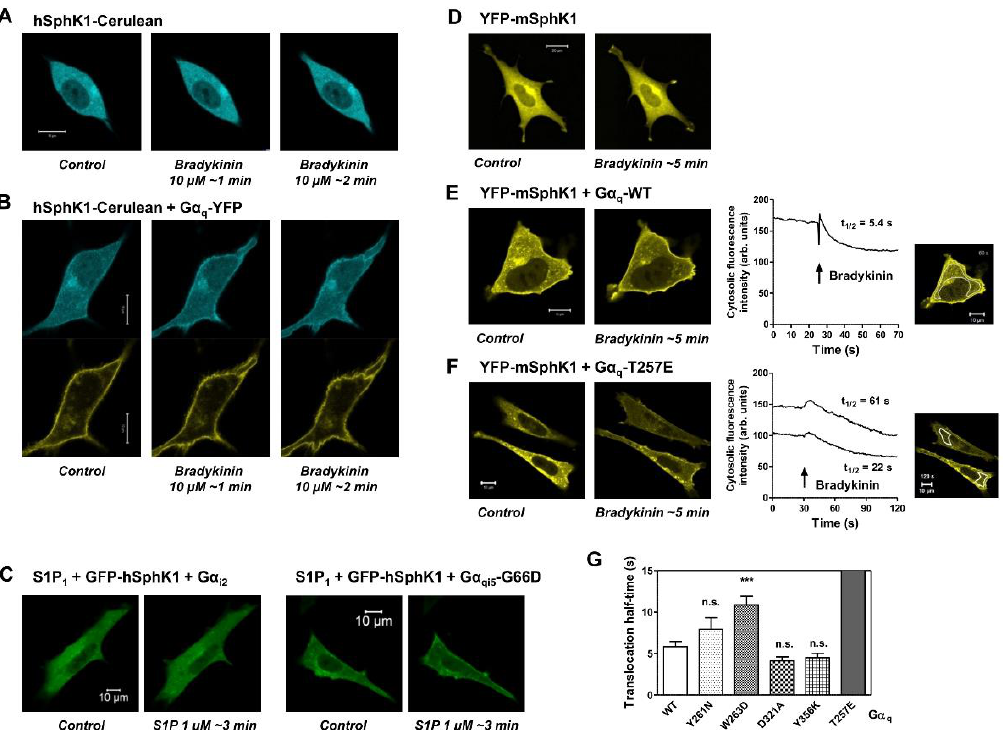
Figure 4. Identification of G α q residues required for G q / 11 -mediated SphK1 translocation. ( A – G ) SphK1 translocation was analyzed in G α q / 11 -double-deficient MEFs. ( A , B ) The cells were co-transfected with the bradykinin B 2 receptor and hSphK1-cerulean without ( A ) and with ( B ) G α q -YFP. Images were taken before and after addition of 10 µ M bradykinin as indicated. ( C ) The cells were co-transfected with the S1P 1 receptor, GFP-hSphK1, and either G α i2 or G α qi5 -G66D as indicated. Images were taken before and ~3 min after addition of 1 µ M S1P. ( D – G ) The cells were co-transfected with the B 2 receptor, YFP-mSphK1, and G α q wild-type (G α q -WT) or various G α q mutants as indicated. Images were taken at a high resolution before and ~5 min after addition of 10 µ M bradykinin. The time course of SphK1 translocation was measured by taking series of images at lower spatial resolution at ~1 image / 400 ms. Cytosolic fluorescence intensity was measured in selected regions as indicated in the inserts in ( E , F ), and translocation half-times were calculated by fitting exponential curves to the decay in the cytosolic fluorescence intensity. ( G ) Translocation half-times obtained with the various G α q mutants. Data are means ± SEM; n = 31 (G α q -WT); n = 14–18 (G α q mutants). Note: n.s., not significant; *** p < 0.0001 in one-way ANOVA followed by Bonferroni´s post-test. The micrometer bars represent 10 µ m. PLC β and p63RhoGEF bind to the e ff ector binding site of G α q primarily via their conserved ALXXPI motifs (X represents any amino acid)